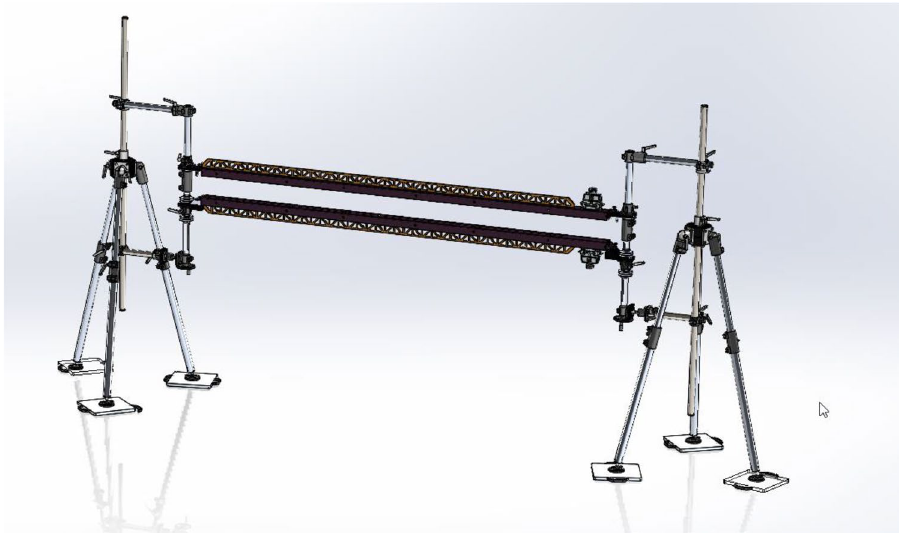
Figure 10. Scheme of the industrial version of the device.